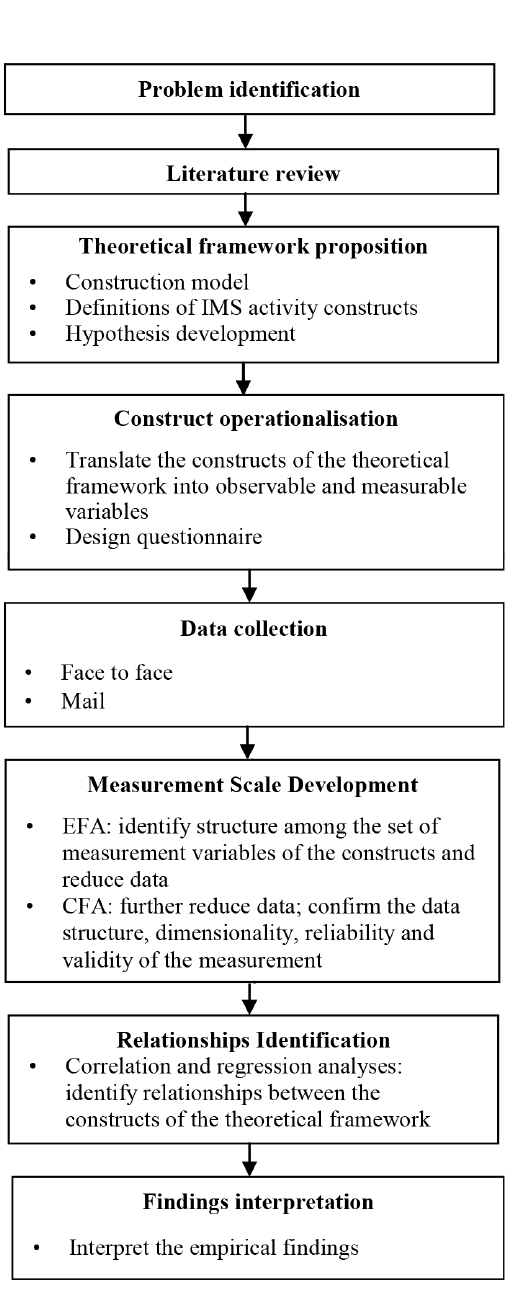
Figure 2. Strategy adopted in this